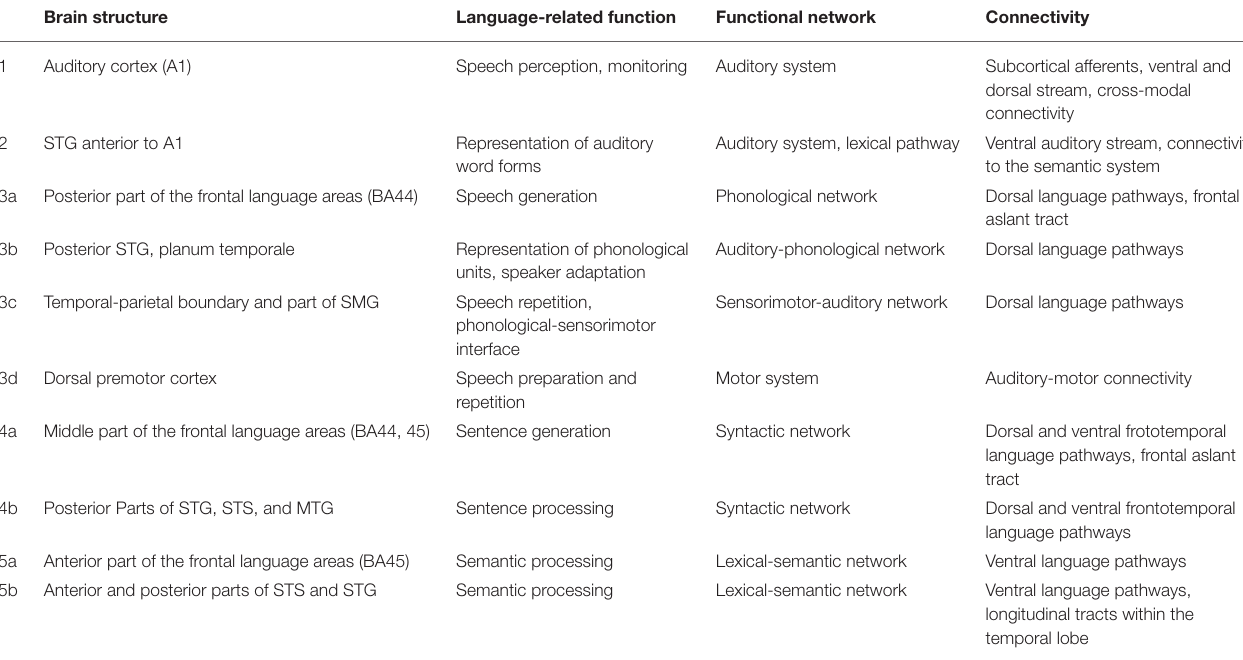
TABLE 1 | Tentative function, network involvement, and most pronounced cortical connectivity patterns of the “core” language areas depicted in Figure 1 (including the auditory